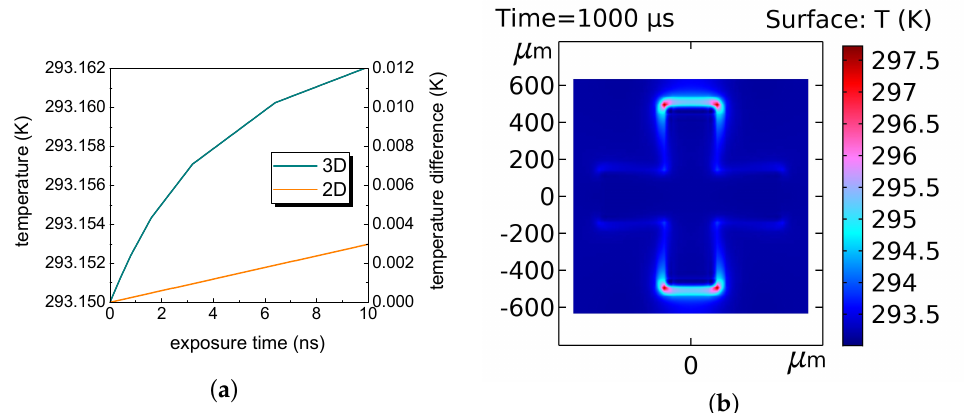
Figure 7. ( a ) Temporal temperature increase in the film obtained with 3D and 2D description. The example of filter on polyimide (PM) substrate under the 0.14 THz radiation exposure. ( b ) Typical temperature distribution in the film. The example of film on PM substrate under the 0.14 THz radiation